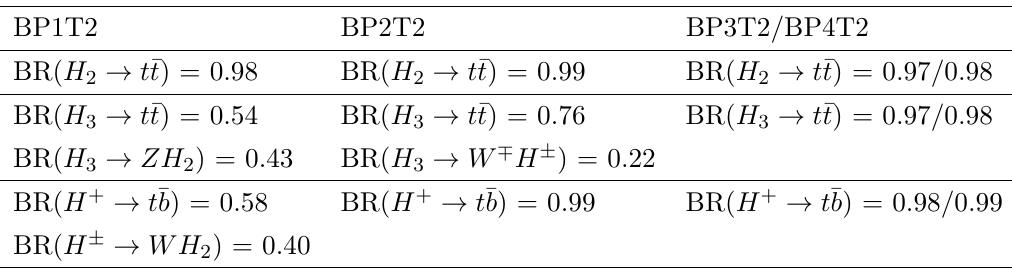
Table 10 . Line 1-8: the input parameters of the type II CP-violating benchmarks with H 1 (cid:17) h and (cid:24) c > 1, compatible with all constraints. Line 9 to 13: the derived 3rd neutral Higgs boson mass, the (cid:24) c value and the CP-odd admixtures R 2 . Line 14: the NLO QCD gluon fusion hh production i 3 cross section at p s = 14